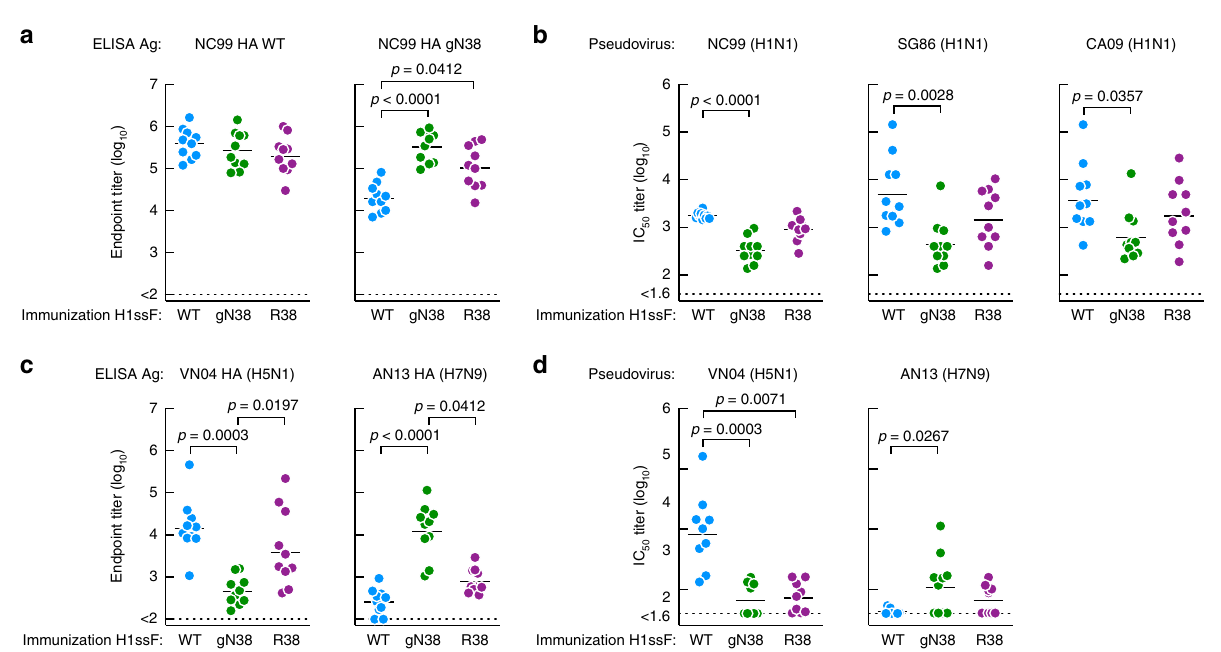
Fig. 2 Immunogenicity of H1 stem nanoparticle variants in mice. BALB/c mice ( N = 10) were immunized with 2 µ g of H1ssF WT, H1ssF gN38 or H1ssF R38 on weeks 0, 4, and 8. Serum antibody titers to HAs were measured at 2 weeks after the third immunization (week 10). a ELISA endpoint titers to H1N1 NC99 HA (left) and its gN38 variant (right). b Serum neutralizing antibody titers to NC99, SG86, and CA09 (H1N1) pseudoviruses. Shown are half- maximal inhibitory dilution of serum (IC 50 ). c ELISA endpoint titers to H5N1 VN04 (left) and H7N9 AN13 HAs (right). d Serum neutralizing antibody titers to H5N1 VN04 and H7N9 AN13 pseudoviruses. Dotted lines indicate the lower detection limit of the assay. Data are presented as scattered dot plots with horizontal lines indicating geometric mean for each group. Statistical analysis was carried out by using nonparametric Kruskal – Wallis test with Dunn ’ s multiple comparisons. Displayed results are representative of two independent experiments (H1ssF WT and H1ssF gN38) or based on one experiment (H1ssF R38). Source data are provided as Source Data fi